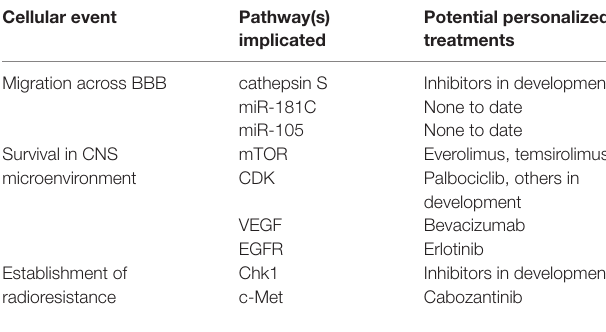
TABLe 2 | examples of metastatic events, their molecular processes, and potential targeted chemotherapeutics. Cellular